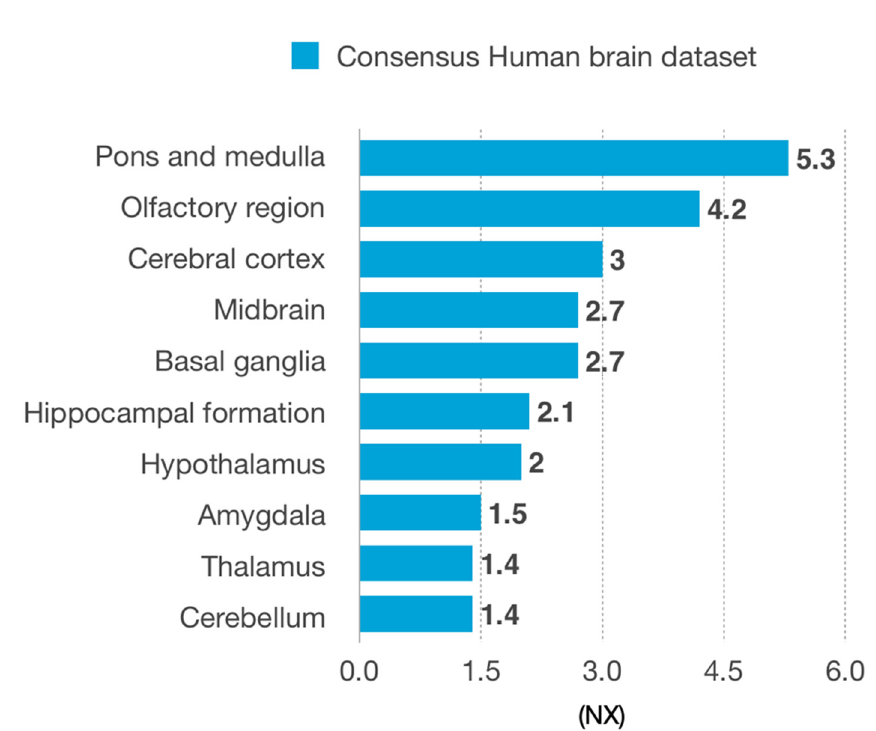
Figure 3. RNA expression of THSD4 gene in different brain regions, according to the Consensus Human Brain Dataset.